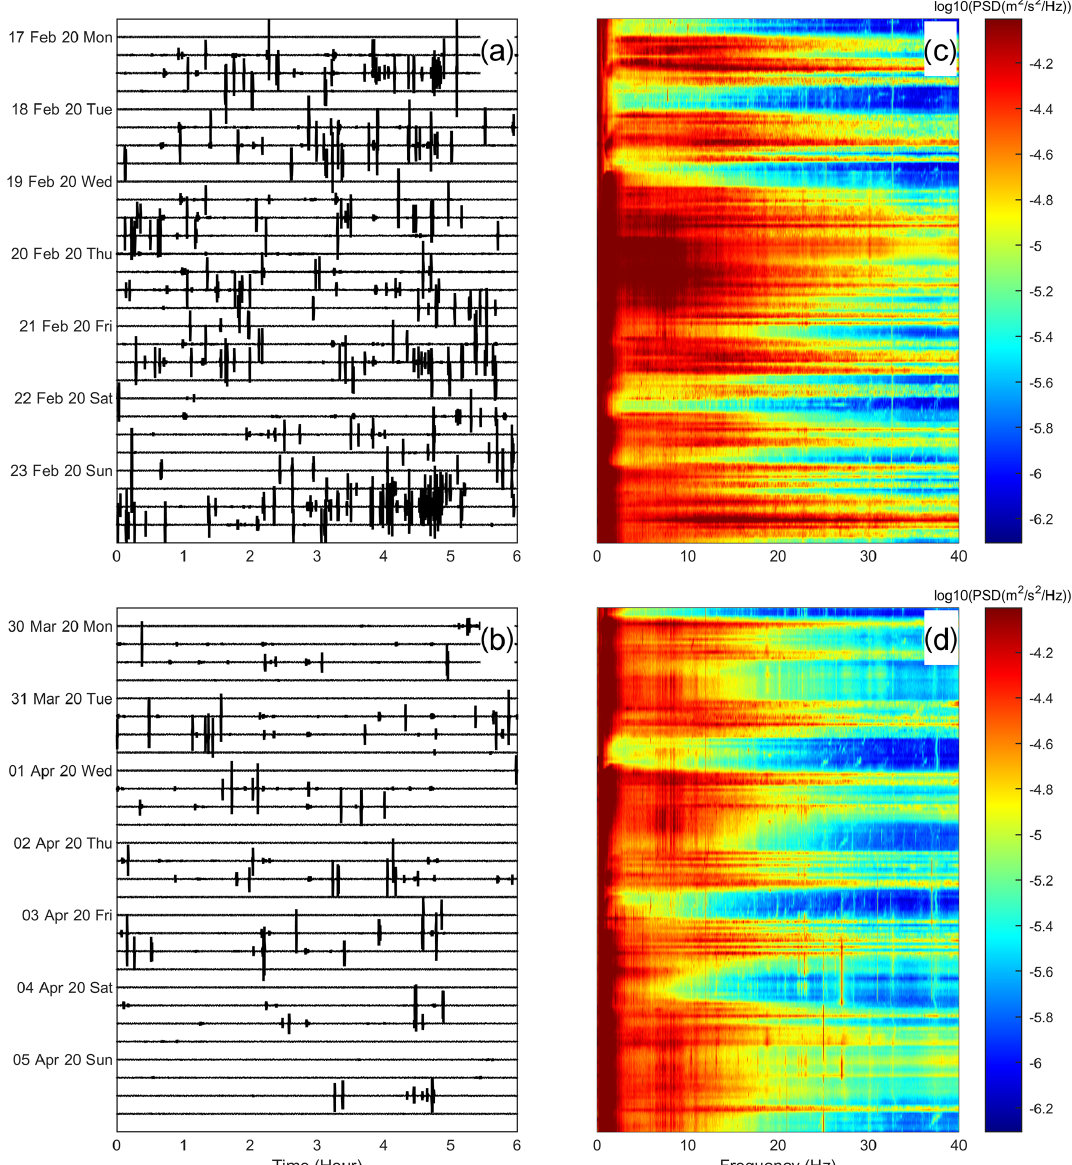
Figure A5. (a) Seismogram showing the seismic signal recorded by the vertical component of the station ILLI and filtered in the band 10–40Hz during the week 17–23 February 2020 and (c) the corresponding spectrogram of the non-filtered signal. (b) Seismogram showing the seismic signal recorded by the vertical component of the station ILLI and filtered in the band 10–40Hz during the week 30 March– 5 April 2020 and (d) the corresponding spectrogram of the non-filtered signal.